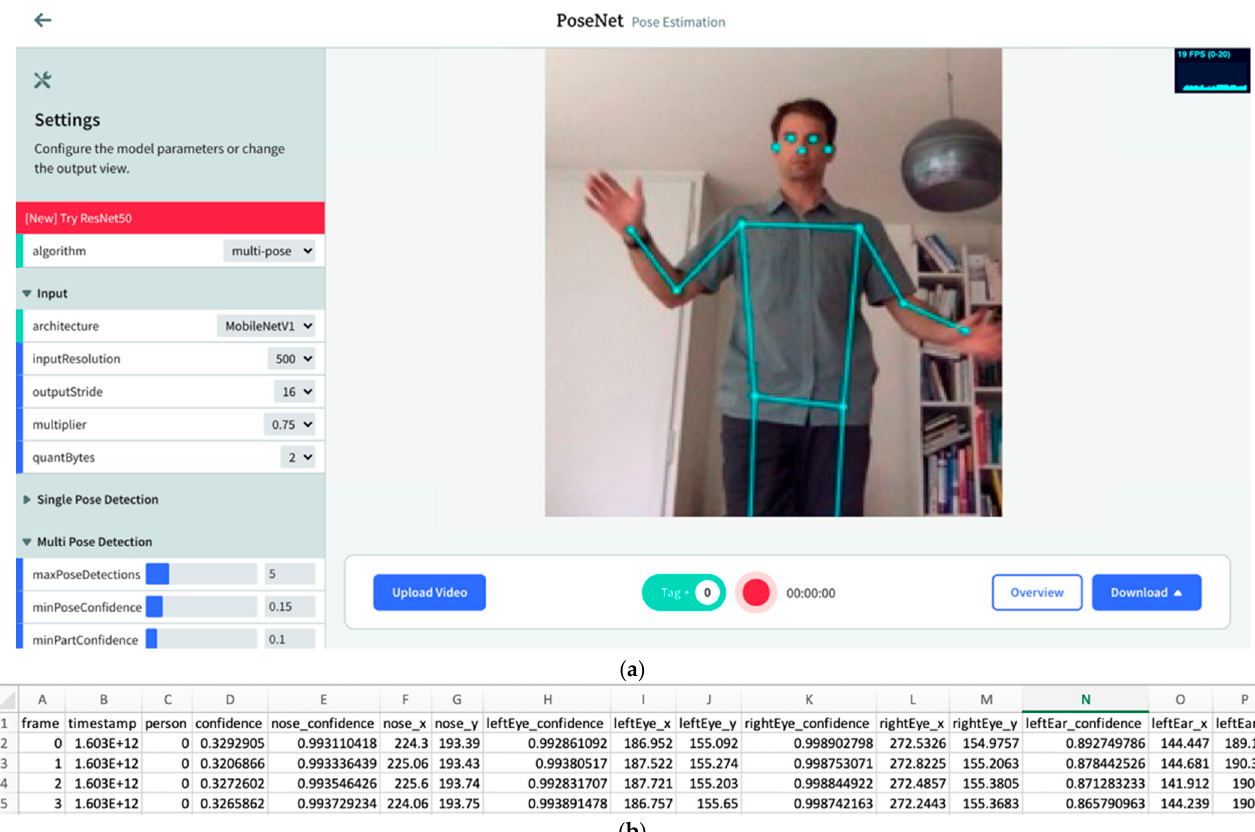
Figure 4. ( a ) The pose-detection tool’s data collection page from the EZ-MMLA Toolkit (PoseNet). This page displays a real-time video recording of the user, with the model’s predicted pose coordinates overlaid on top. In the top-right corner of the screen, there is an information box displaying the rate at which each frame is being processed per second by the model. In the left corner, there is a controller to change the various configurations of the model as well as the display output. At the bottom of the screen, there is a recording bar that contains (1) a recording button to start and stop data recording, (2) an overview button to provide a summary of the data collected in a recording, (3) a download button to save the generated data as a CSV file, (4) an upload video button for pro- cessing pre-recorded videos, and (5) a tag button to add tags to the data as the recording takes place. ( b ) A snippet of the CSV file of the data collected by PoseNet (i.e., frame number, timestamp, and for each body joint, the x, y predicted coordinates and the associated confidence level of that pre- diction).